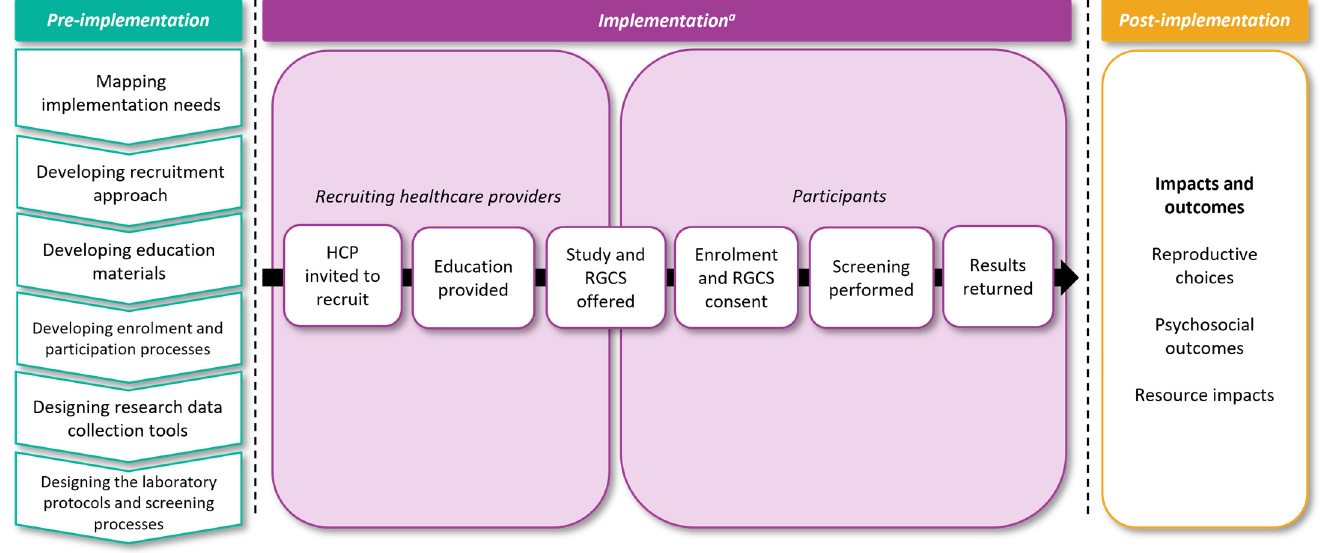
Figure 2. Mackenzie’s Mission’s study design showing the implementation phases. a The processes were piloted in four states/territories (Phase 2a) before national implementation (Phase 2b).